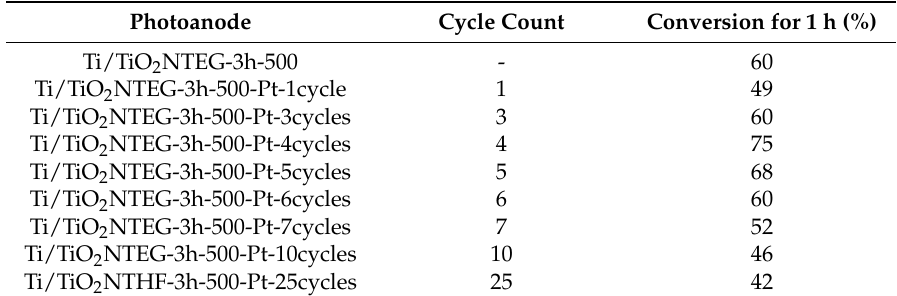
Table 5. PEC experiment results of Ti/TiO 2 NTEG-3h-500-Pt-Xcycles photoanodes. [paraquat]: 37.4 µ M, applied potential vs. Ag/AgCl: 1.0